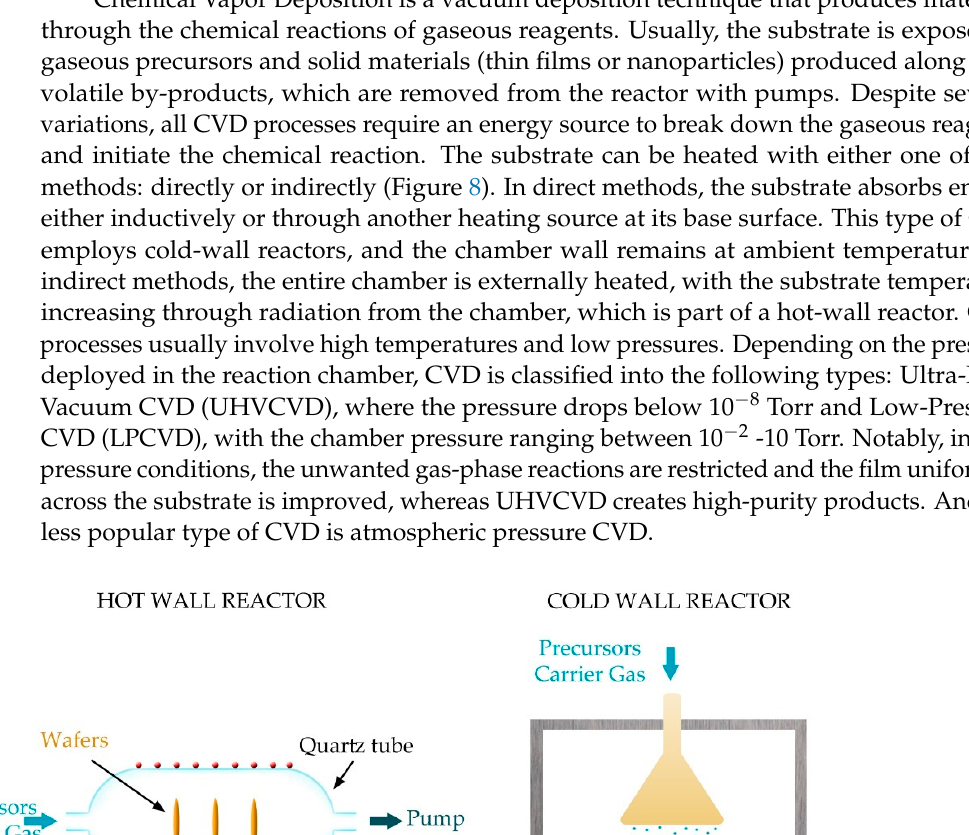
Table 1. Overview of production methods for magnetic core/shell nanoparticles.